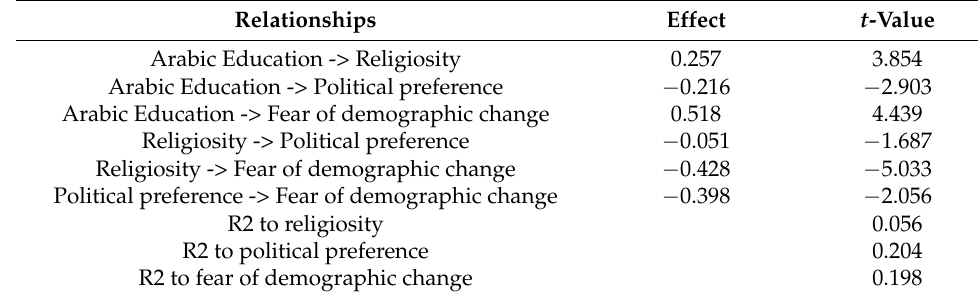
Table 4. The summary of significance and relevance